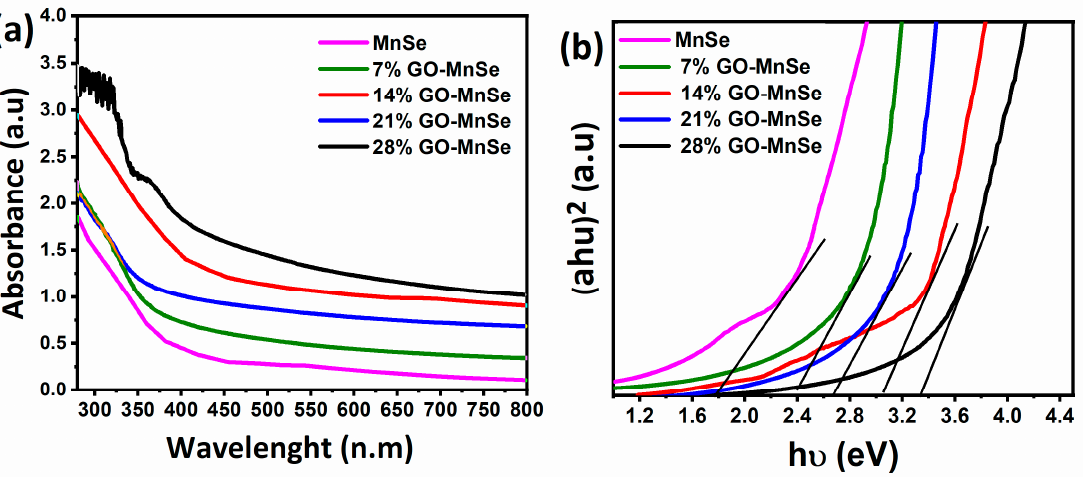
Figure 5. ( a ) DRS spectra ( b ) bandgap energy of MnSe, 7% GO-MnSe, 14% GO-MnS, 21% GO-MnSe, and 28% GO-MnSe.